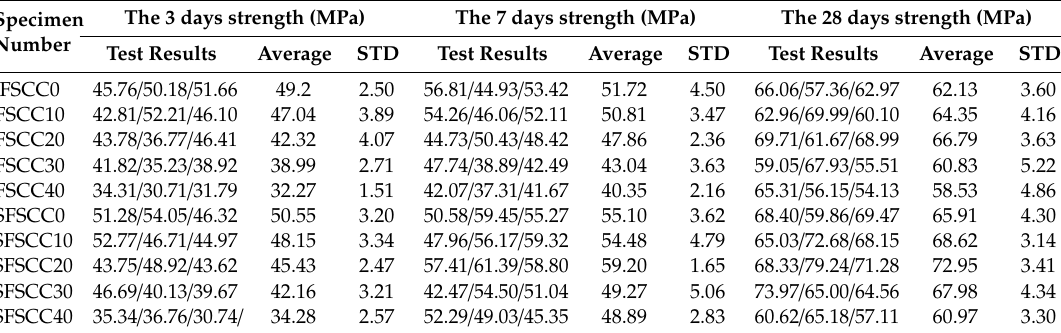
Figure 5. Results of SCC compressive strength test. Table 4. Test results of 3 days, 7 days and 28 days compressive strength of SCC.